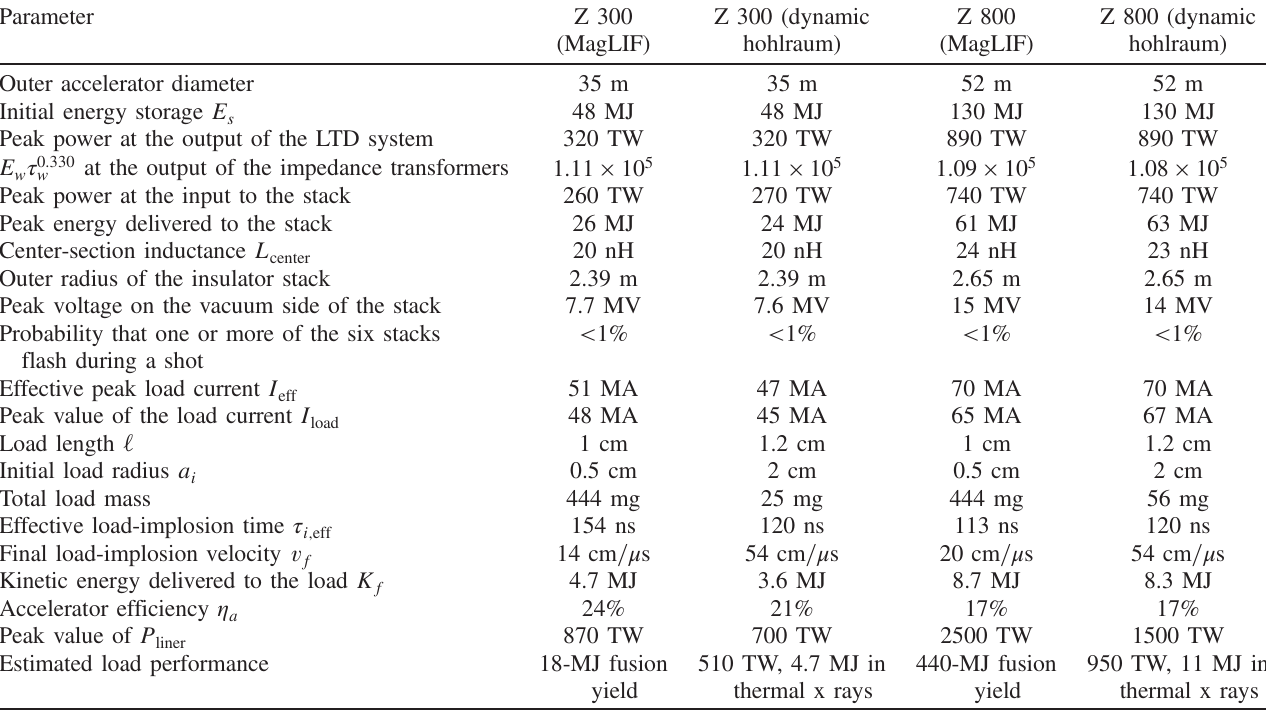
TABLE I. Z-300 and Z-800 accelerator and load parameters. The second and fourth columns of the table assume a MagLIF load; the third and fifth assume the load is a dynamic hohlraum. The center-section inductance L is defined by Appendix C. The effective center peak pinch current and implosion time are calculated as described by Appendix D. The final load-implosion velocity v f , kinetic energy delivered to the load K f , and accelerator efficiency η a are — for the two simulations conducted with a MagLIF load — calculated when the load has achieved a 10:1 convergence ratio. For the two simulations conducted with a dynamic hohlraum, these quantities are calculated when the load has achieved a 6.7:1 convergence ratio. The fusion yields given in the last row are estimated using 2D MHD simulations [69]. The peak x-ray powers and total x-ray yields assume the dynamic hohlraum can be considered as an ablation-dominated wire-array z pinch [105,106], which suggests its radiated power and energy scale as indicated by Eqs. (54) and (55), respectively.